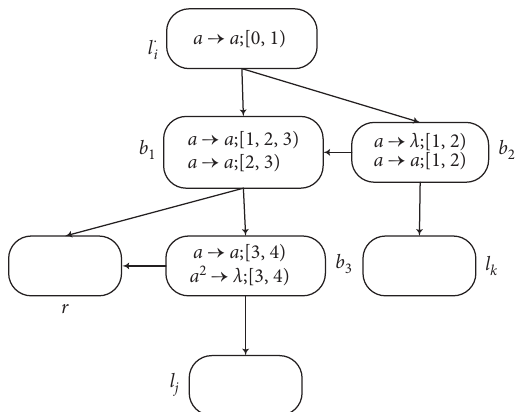
Figure 2: Module ADD: simulating the ADD instruction : ( ADD ( r ) ,l , l ) l i j k